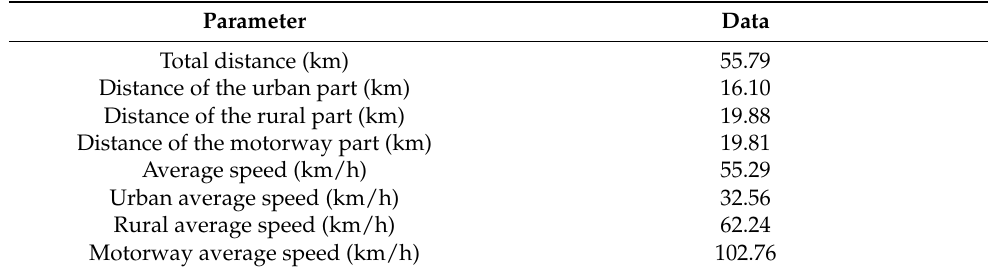
Table 2. Specification of the on-road emission test.